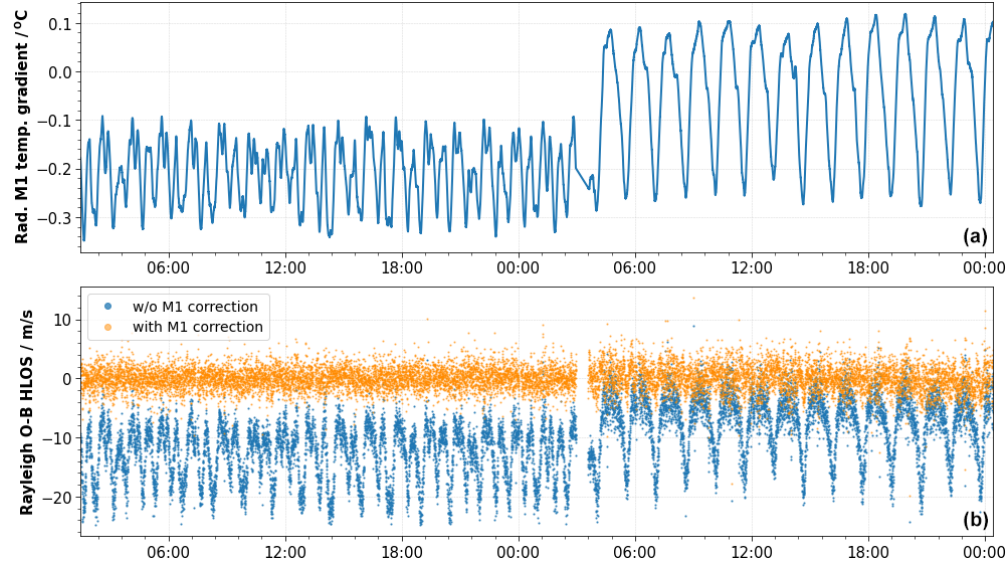
Figure 12. The radial temperature gradient of the M1 telescope (a) and the Rayleigh clear E(O − B) HLOS values (b) as a function of time during the M1 optimization tests on 5 and 6 July 2020. The blue and the orange dots indicate the bias without and with M1 bias correction, respectively. Data from day N are used to predict the bias on day N . The periodicity (especially visible in the second half of the plot) is related to the orbital phase of the satellite which is ∼ 91m.